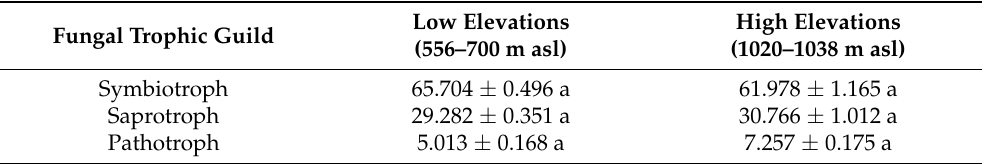
Table 6. The trophic mode-based community structure of soil fungal communities in the forests at the low and high elevations on Wuyi mountain.